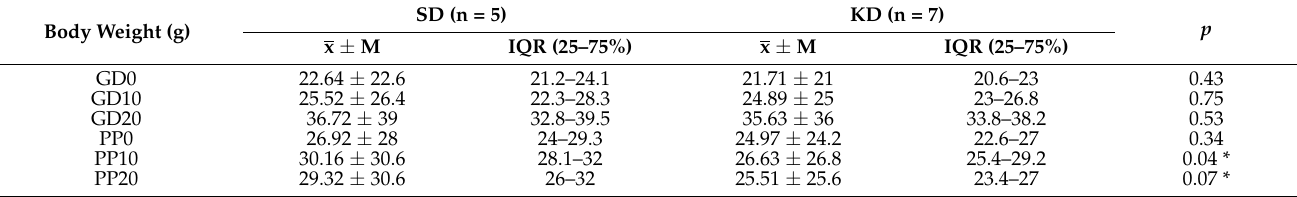
Table 1. Maternal body weight.